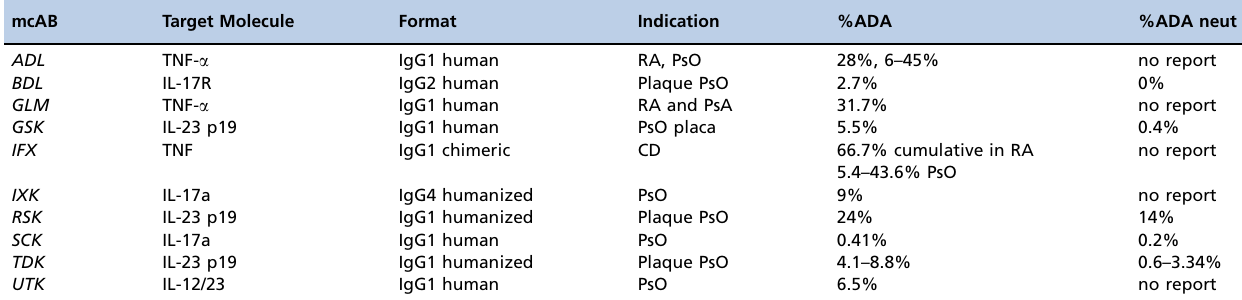
Table 2 - Monoclonal antibodies approved for the treatment of psoriasis and psoriatic arthritis, and the anti-drug antibodies (ADAs) rates reported for them (1,34).